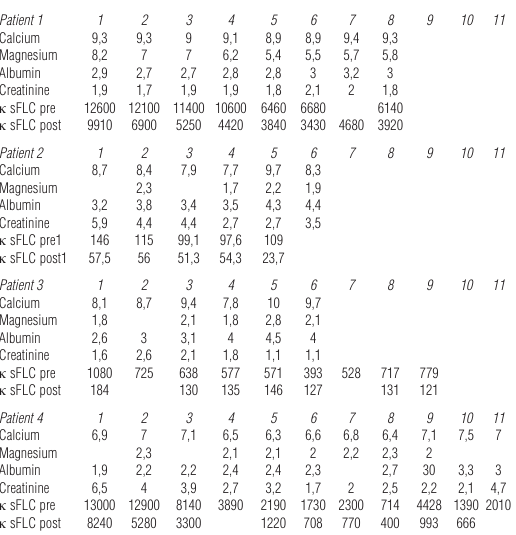
Table1. Pre-dialysis value of: calcium, magnesium, albumin and creatinine and Pre and post-dialysis value of kappa serum free light chain. Numbers (1, 2, 3...) refers to successive dialysis ses- sions (days). In patient 4, betweeen dialysis session n° 8 and n° 9 passed a 5 days period.